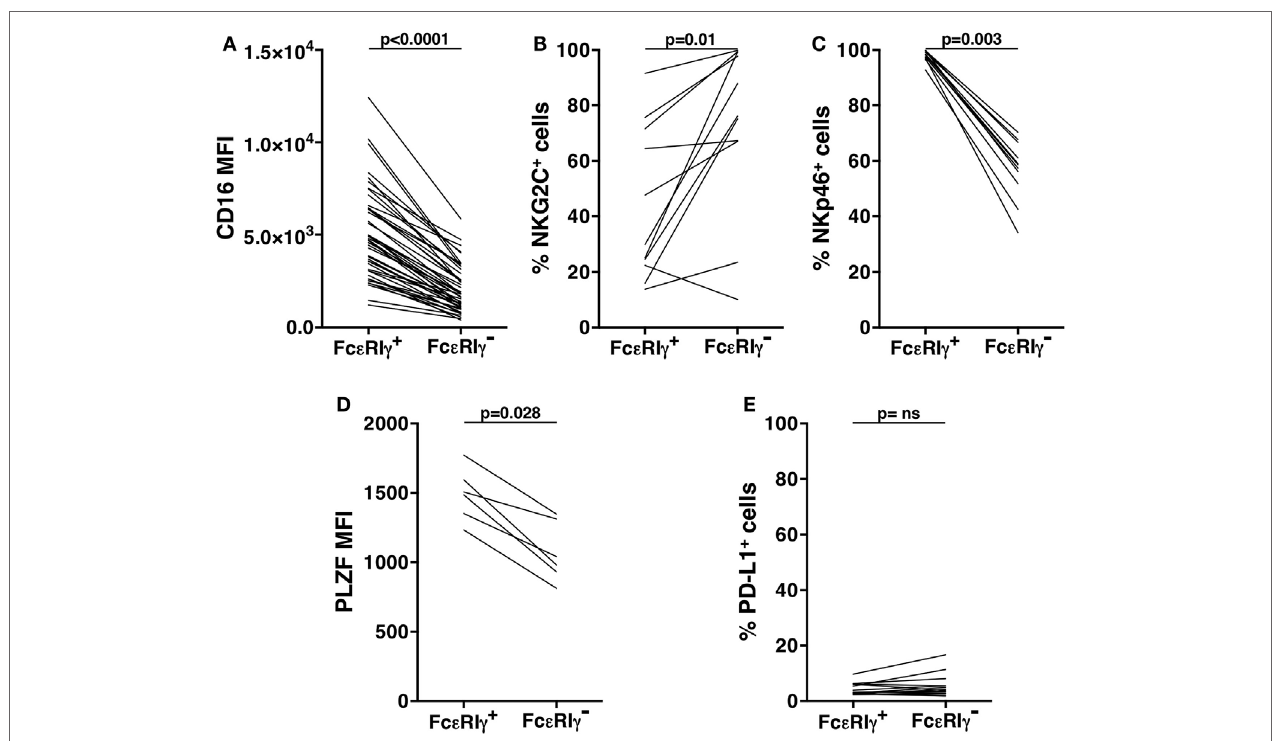
FigUre 4 | Phenotypic characterization of in vitro cultured human memory natural killer (NK) cells. CD16 mean fluorescence intensity (MFI) (a) , frequency of NKG2C + (B) , and of NKp46 + (c) cells, pro-myelocytic leukemia zinc finger (PLZF) MFI (D) , and percentage of PD-L1 + (e) cells, were evaluated on memory (Fc ε RI γ − ) and conventional (Fc ε RI γ + ) CD3 − CD56 dim CD16 + NK cells, upon co-culture with rituximab-opsonized Raji cells. p values of pairwise comparisons are from Wilcoxon non-parametric